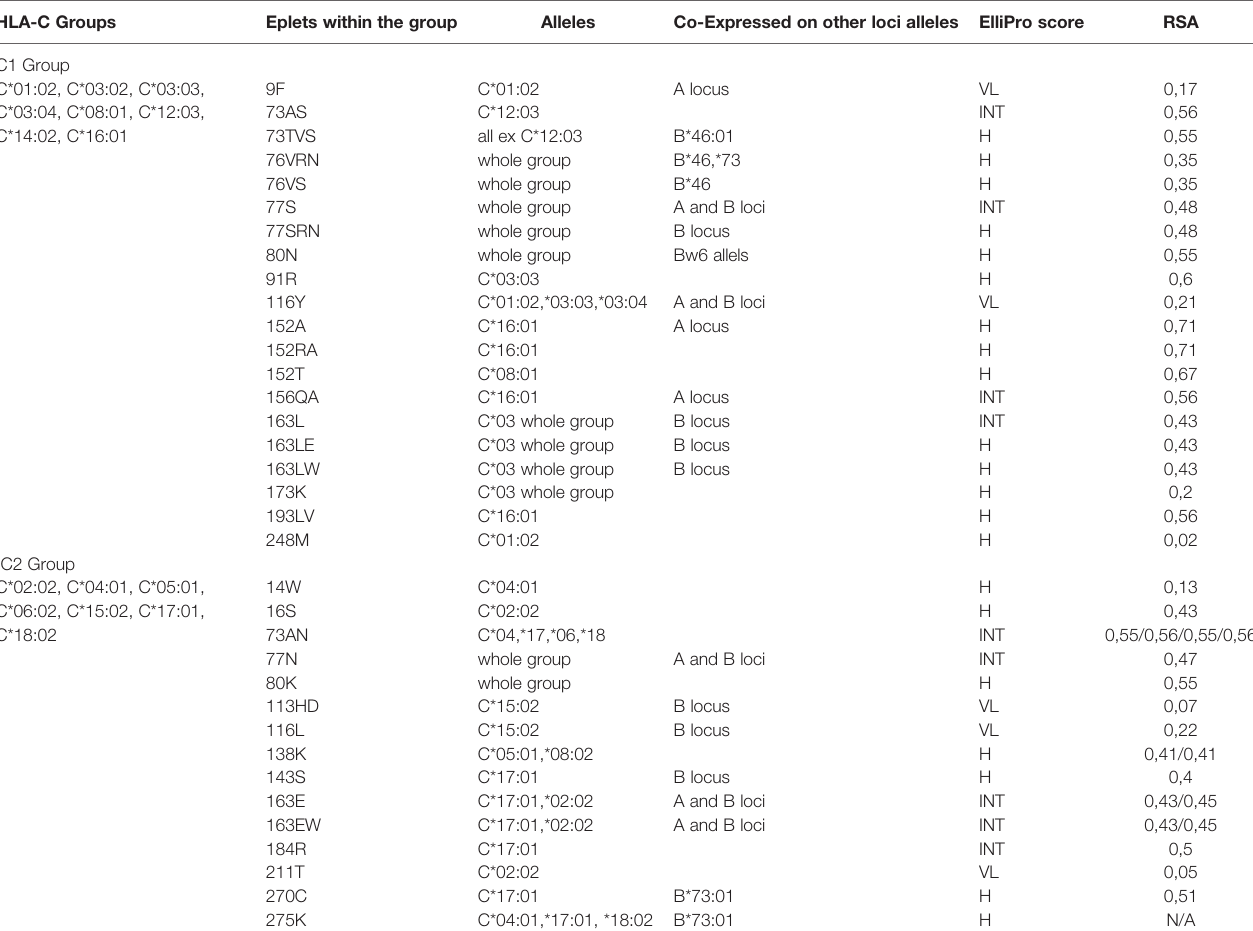
TABLE 2 | Antibody veri fi ed eplets for the two PCA de fi ned HLA-C groups with the One Lambda bead array assay. HLA-C Groups Eplets within the group Alleles Co-Expressed on other loci alleles ElliPro score